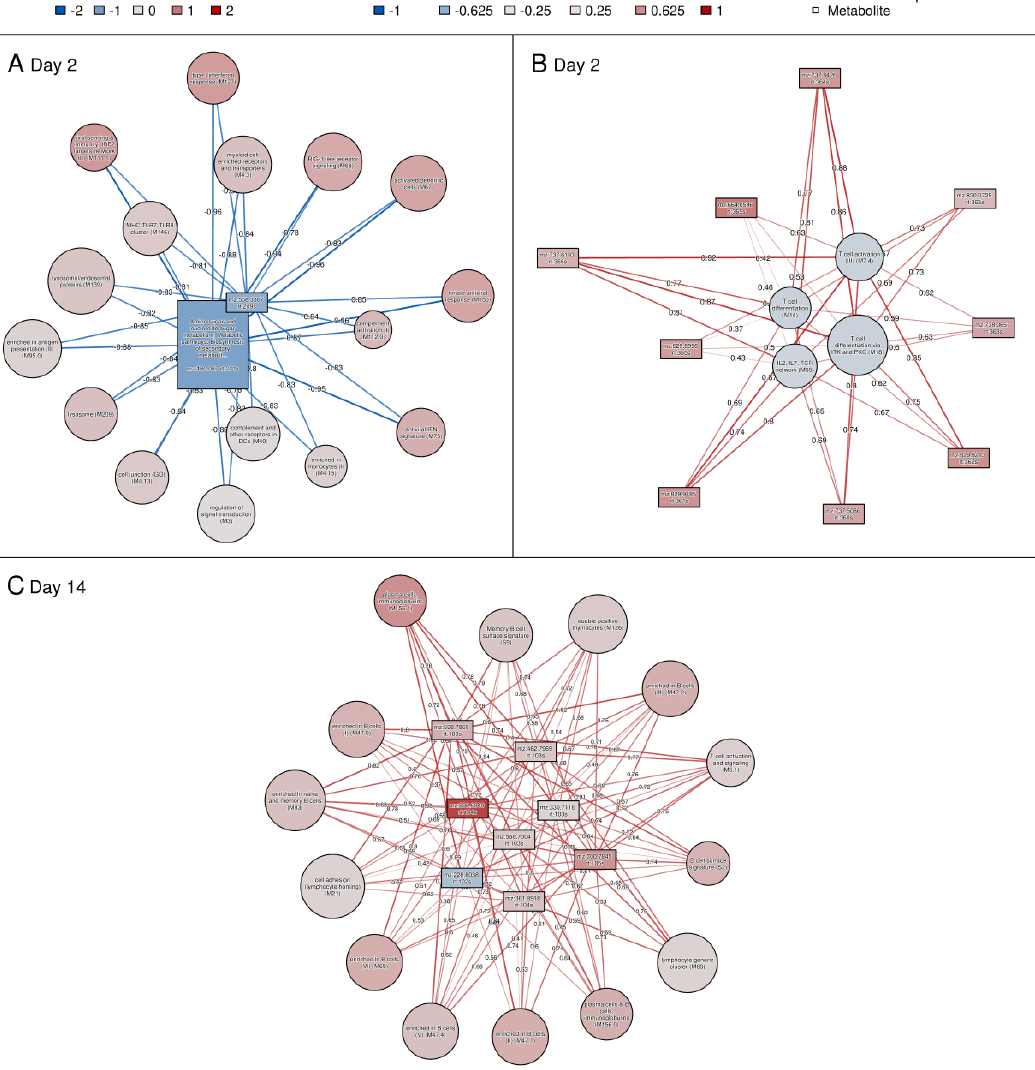
Figure 7. Blood Transcription Module gene expression changes that were correlated with metabolite changes. Node color gradient encodes fold change from pre-vaccination. In red: up-regulated compared to pre-vaccination; in blue: down-regulated compared to pre-vaccination. Edges represent correlation between Blood Transcription Modules and metabolite responses. Edge thickness and edge color is scaled with increasing correlation. Circles represent Blood Transcription Modules. Boxes are used for metabolites. Metabolites are labeled by mass-to-charge ratio ( m / z ) and retention time (rt). In addition, mappings to KEGG metabolic pathways are included as part of metabolite labels if a matching KEGG compound could be identified. For example, the metabolite peak with m / z = 180.087 and rt = 211s is a tentative match to protonated glucosamine by accurate mass and was linked to the Amino sugar and nucleotide sugar metabolism and Metabolic KEGG pathways (Table SD6). ( A ): Day 2 IFN-γ signature; ( B ): Day 2 T cell signature; ( C ): Day 14: B cell signature. KEGG pathway information was added for metabolites with an annotation confidence score ≥ 2 based on HMDB mappings. 4. Discussion The effective component of the DVC-LVS vaccine is live-attenuated F. tularensis , a highly pathogenic bacterium whose strong virulence has been attributed to its ability to evade and alter the